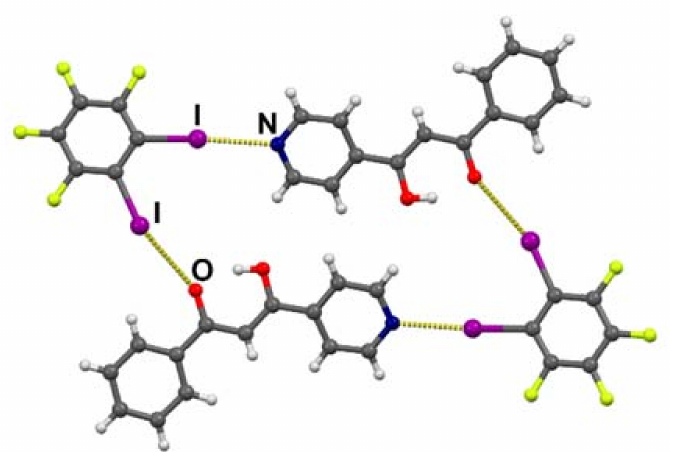
Figure 4. Centrosymmetric dimer formed through I ··· O and I ··· N halogen bonds in ( b4pm )( 12tfib ). Hydroxyl hydrogen atoms were found from the electron difference map.